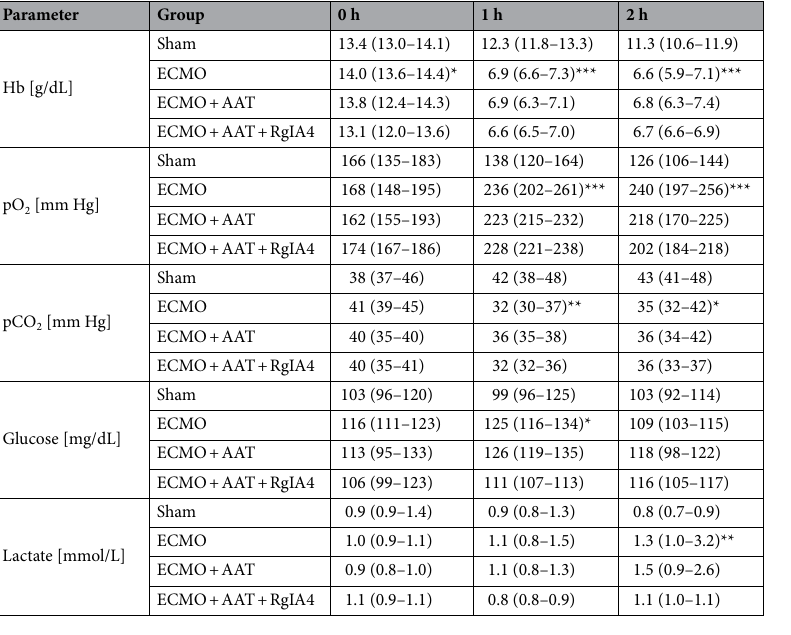
Table 1. Blood parameters. Data are presented as median and interquartile ranges (25th and 75th percentile); Kruskal–Wallis test followed by pairwise Wilcoxon–Mann–Whitney test. AAT α-1-antitrypsin, ECMO extracorporeal membrane oxygenation, Hb haemoglobin, pO 2 oxygen partial pressure, pCO 2 carbon-dioxide partial pressure. * p ≤ 0.05; ** p ≤ 0.01; *** p ≤ 0.001; *sham vs.